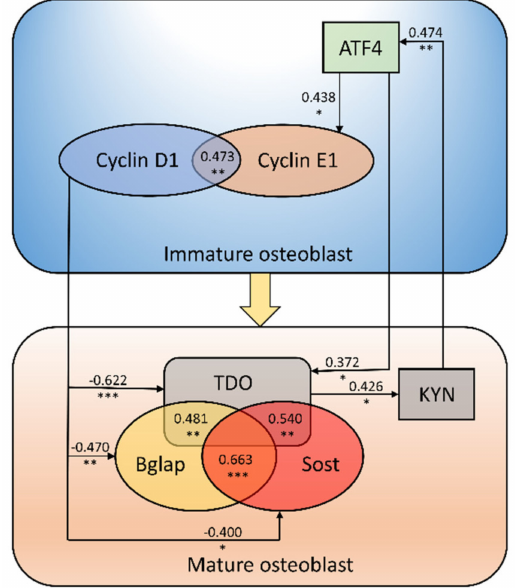
Figure 8. Schematic presentation of the possible role of bone kynurenic pathway activation in the osteoblast maturation process. Each value is Spearman’s rank correlation coe ffi cient ( R ) value between the genes. * p < 0.05, ** p < 0.01, *** p < 0.001 indicate statistically significant values; a negative value indicates an inverse correlation between parameters. ATF4—activating transcription factor 4; Bglap—osteocalcin; KYN—kynurenine; Sost—sclerostin; TDO—tryptophan